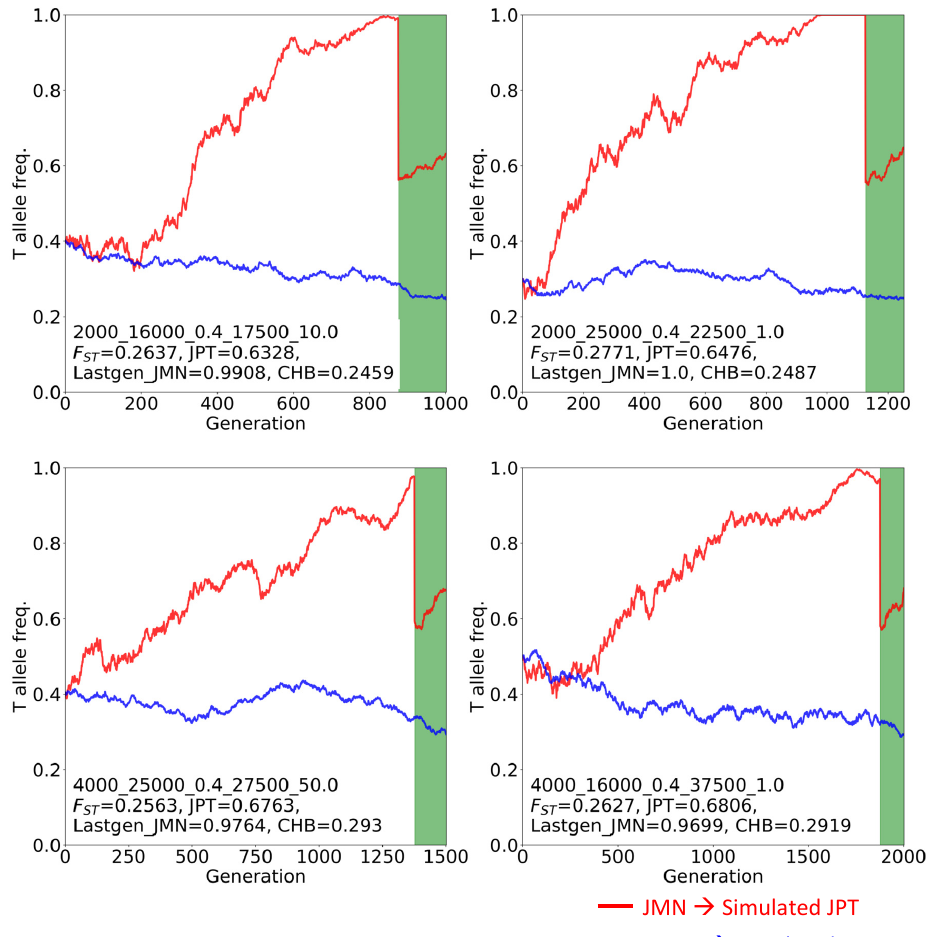
JMN  Simulated JPT